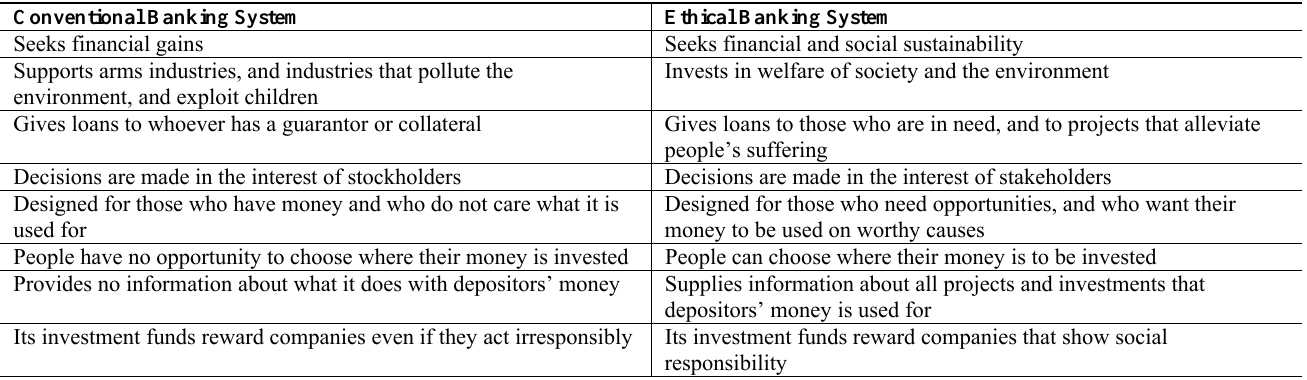
Table 1: Characteristics of Ethical vis à vis Conventional Banking Systems Conventional Banking System Ethical Banking